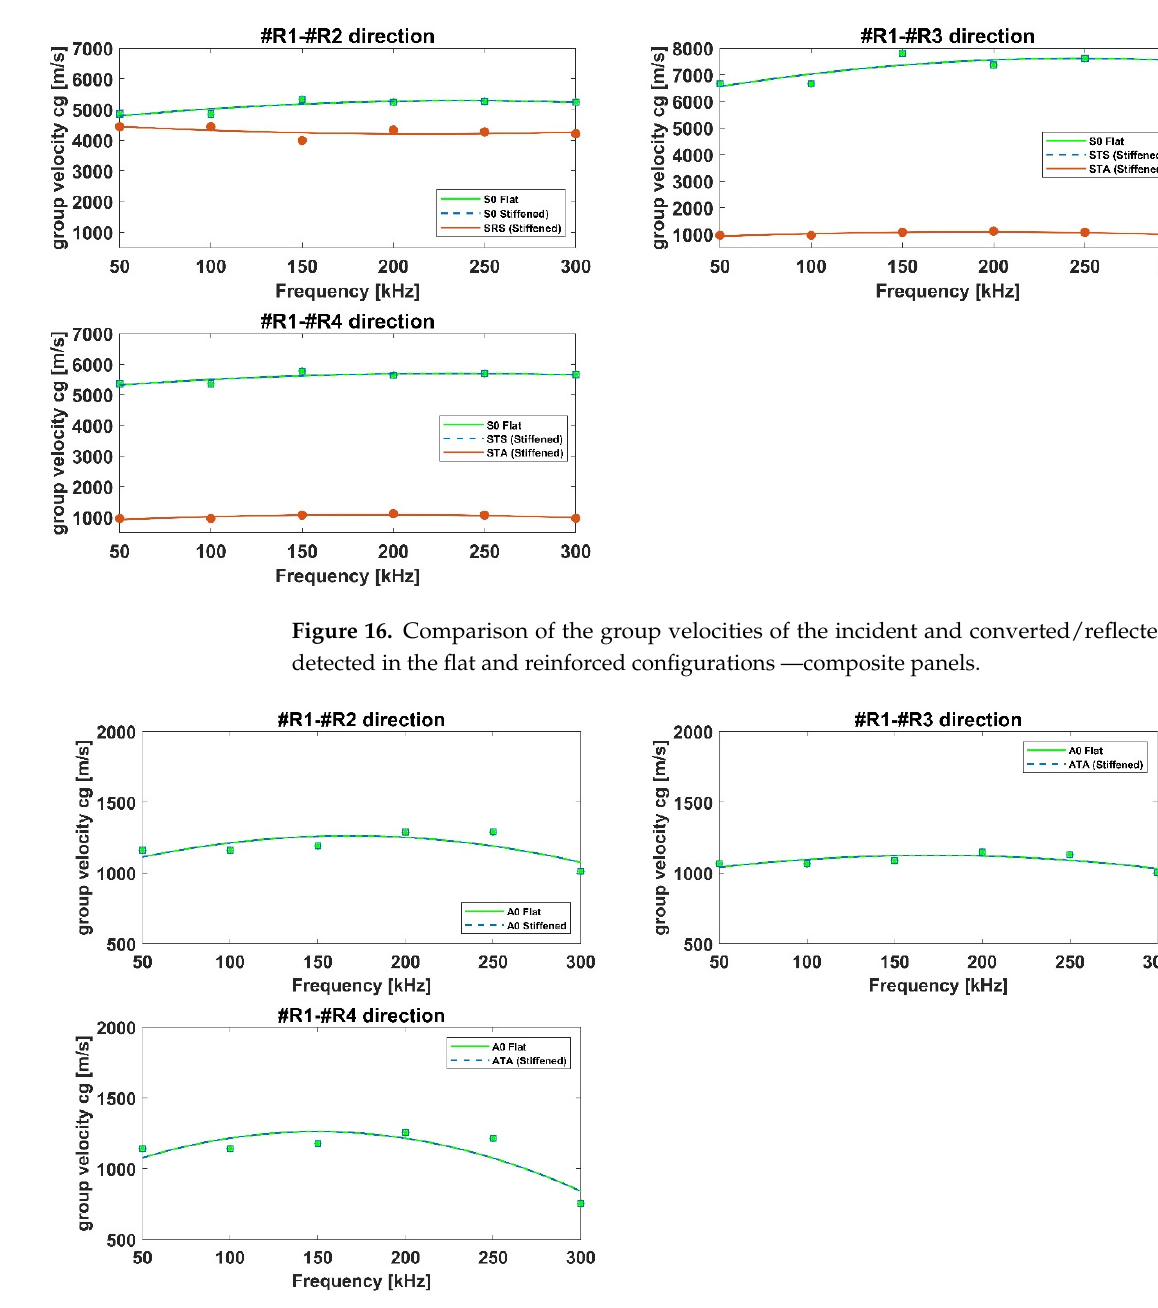
Figure 17. Comparison of the group velocities of the incident and converted/reflected A 0 modes detected in the flat and reinforced configurations – composite panels.